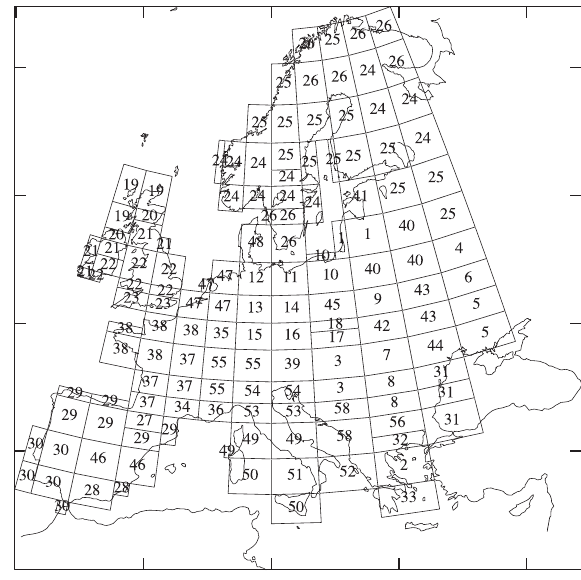
Fig. 2. Blocks of the European conductivity map Adam et al. (2012). Blocks 24–26 cover Norway (Table 2).